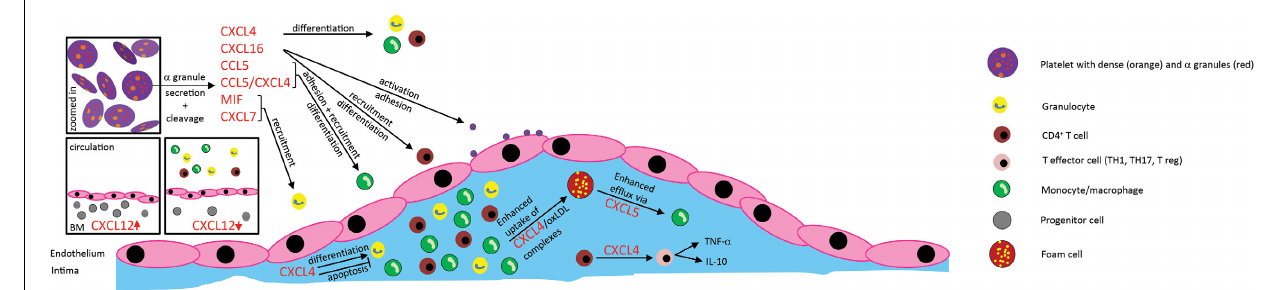
FIGURE 1 | Effects of platelet-derived chemokines on inflammatory cells and atherogenesis. Chemokines are stored in α -granules and secreted upon activation. Most platelet-derived chemokines act on the one hand on inflammatory cell differentiation and apoptosis. On the other hand, they act on